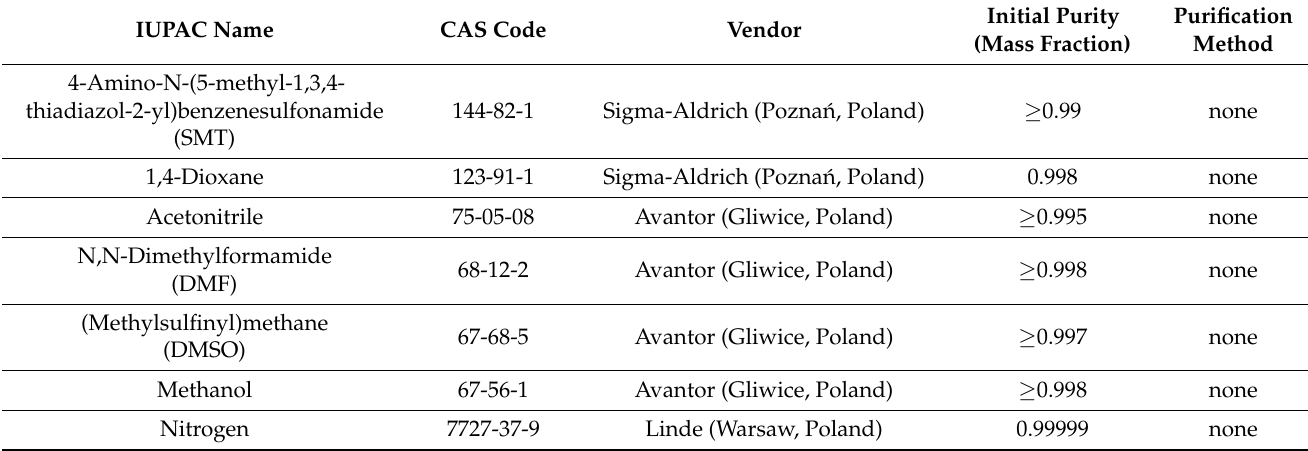
Table 1. The characteristics of chemicals used in the